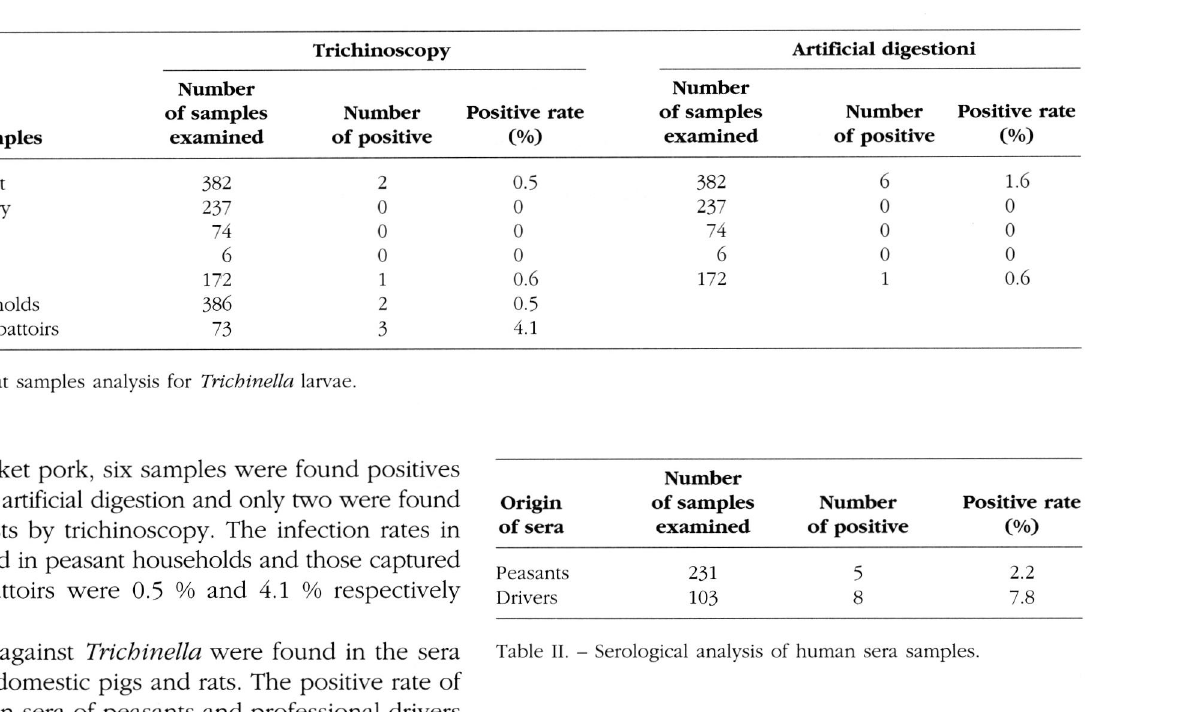
Table II. - Serological analysis of human sera